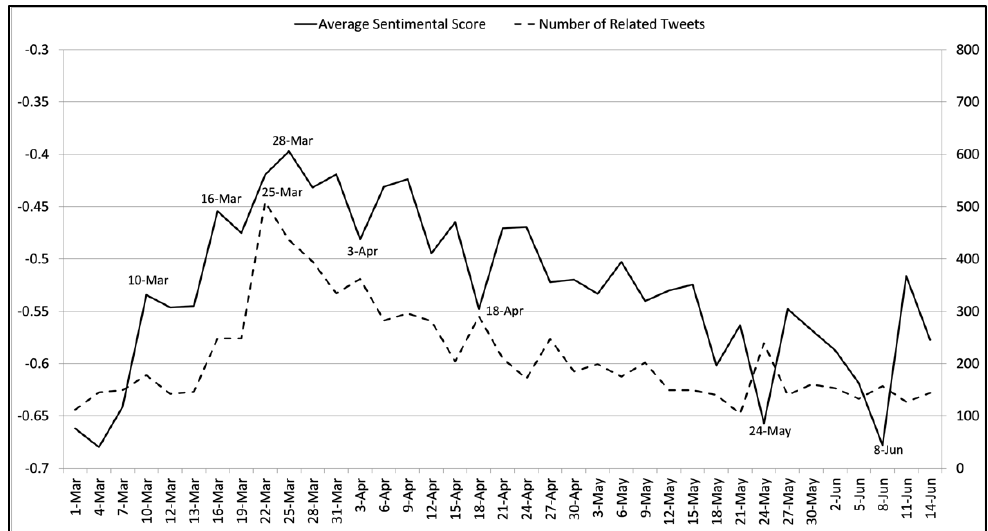
Figure 4. The average sentiment scores and the numbers of tweets related to the stay-at-home policy on each collection day from 1 March 2020 to 14 June 2020. The left vertical axis indicates average sentiment scores, while the right vertical axis suggests the number of related tweets collected. The horizontal axis shows the collection dates.